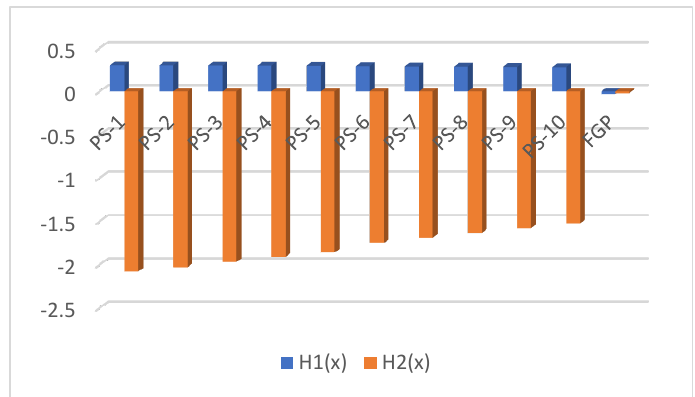
Figure 3. Comparison of objectives of second level with FGP.